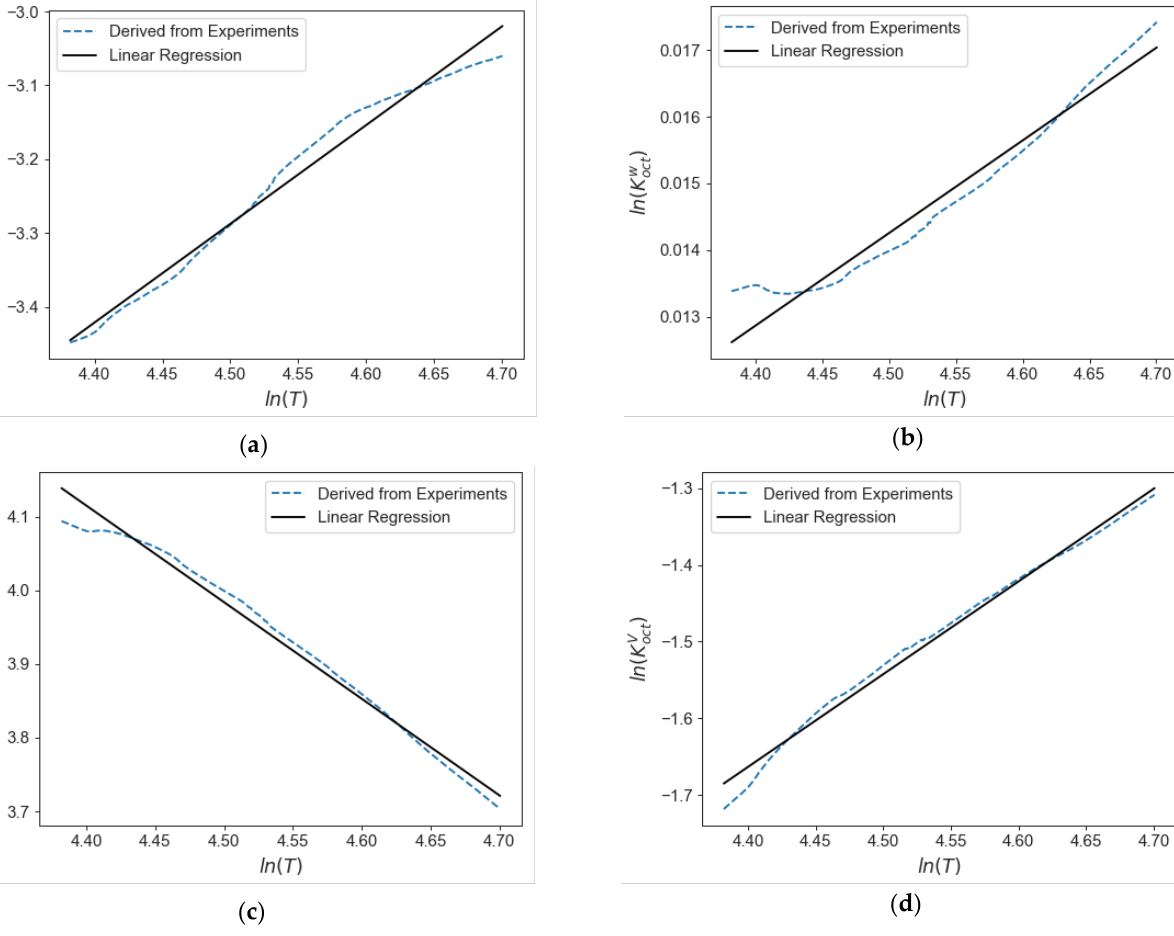
Figure 20. K values calculated from experimental data in the CREC VL-Cell for water/n-octane mixtures: ( a ) K value for water in W phase, ( b ) K value for octane in W phase, ( c ) K value for water in V phase, ( d ) K value for octane in V phase.